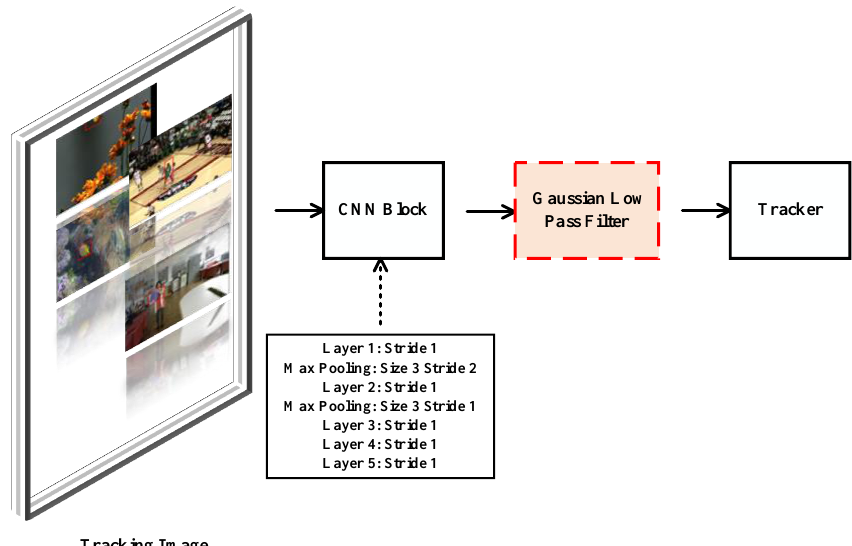
Figure 9. Overview of the proposed architecture with Gaussian low pass filter.